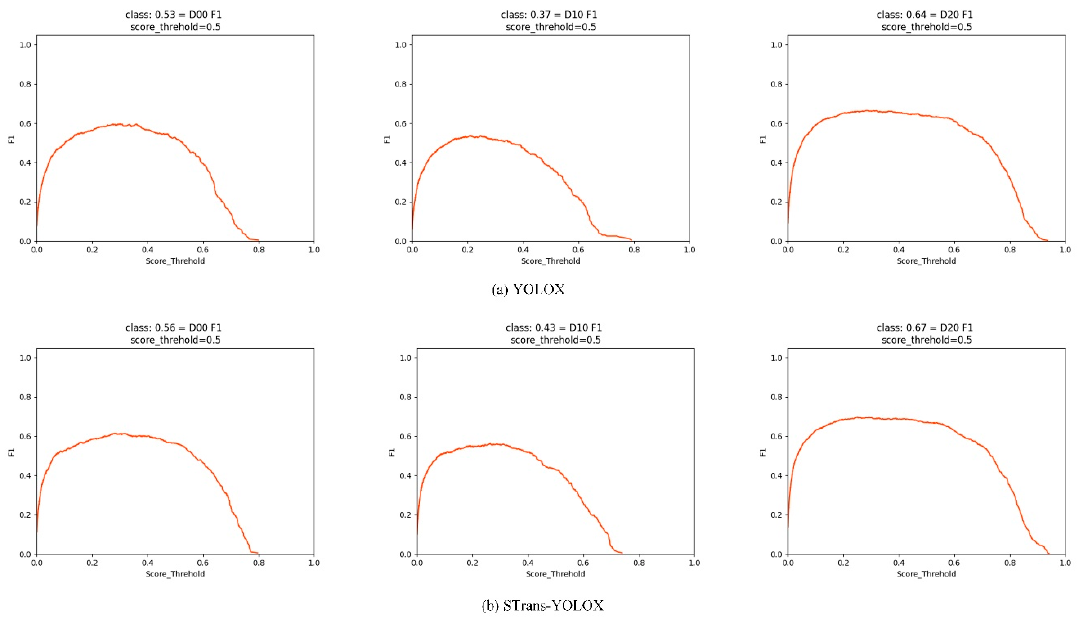
Figure 7. F1-Score curves of YOLOX and STrans-YOLOX of three classes of cracks.